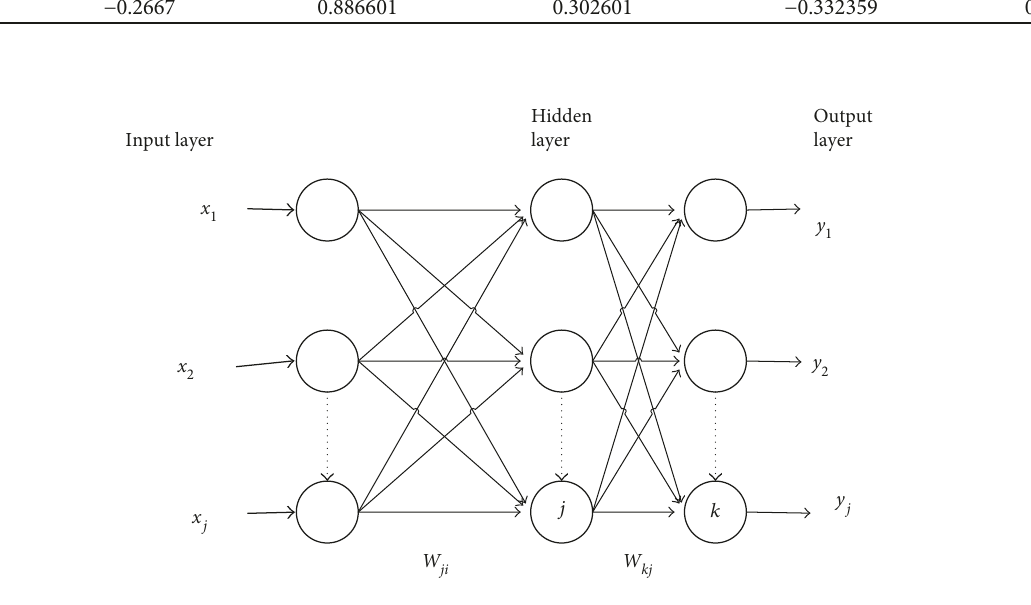
Figure 2: Structure of BP